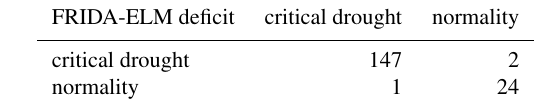
Table 4. State index confusion matrix.